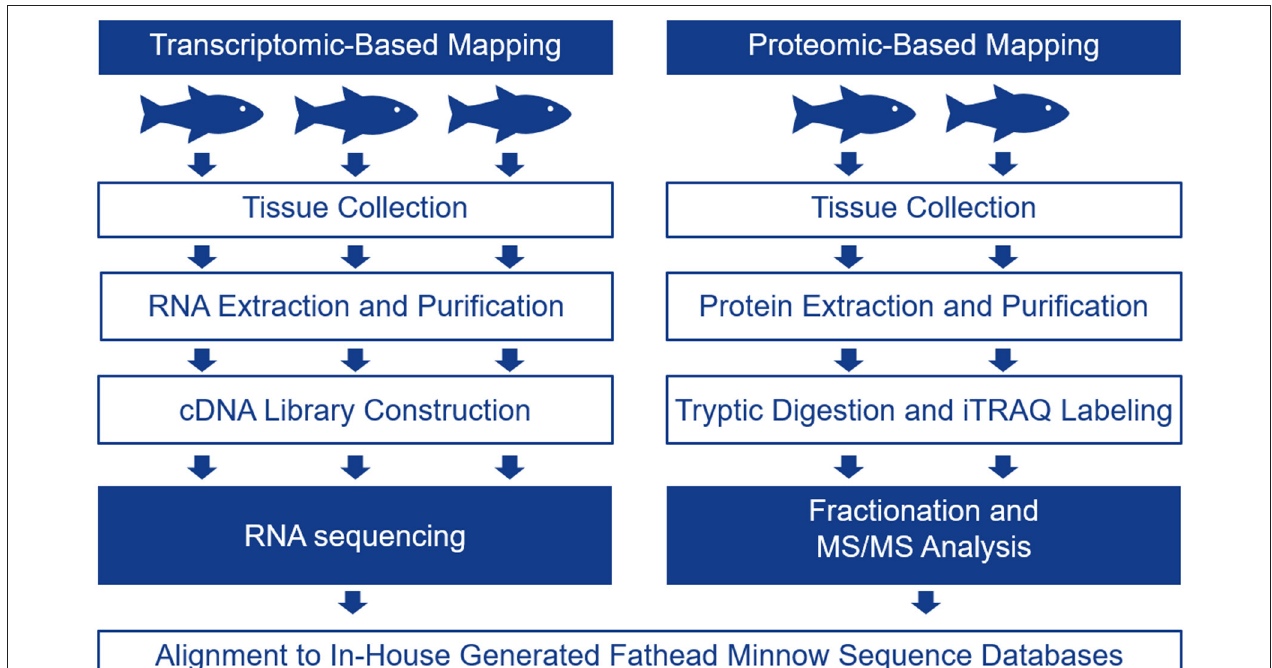
FIGURE 1 | Schematic showing the experimental protocol followed to generate tissue-specific mRNA and protein data for four tissues including the telencephalon, hypothalamus, liver, and gut. Tissue-specific mRNA expression was evaluated with RNA-seq using 3 male biological replicates while tissue-specific protein expression was evaluated using iTRAQ in 2 male biological replicates.